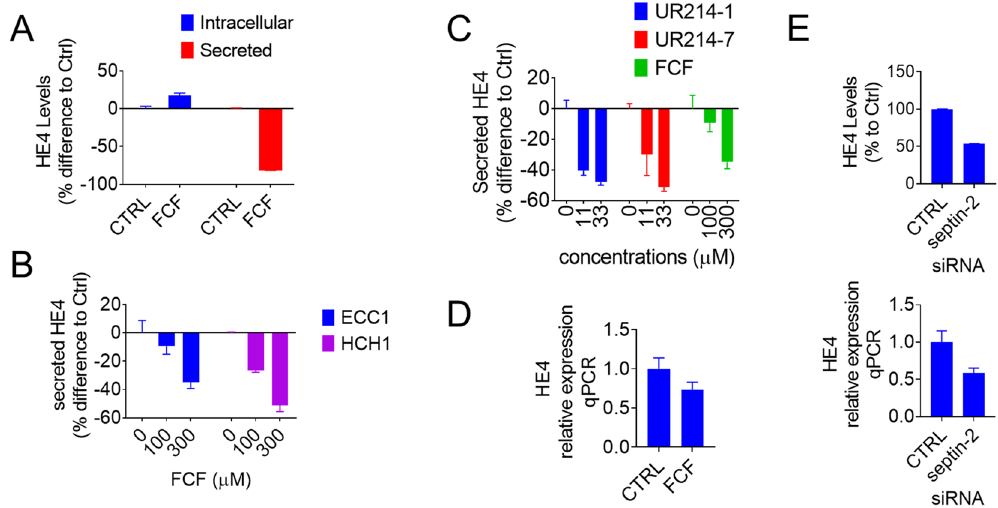
Figure 4. The effect of FCF analogs on the expression of HE4. ( A ) HE4 overexpression clones (OVCAR8-C5) were treated with or without FCF (300 µ M) for 7 h, after which the cell lysates and matching culture media were collected and analyzed for the levels of HE4 using enzyme immunoassays. The amount of secreted HE4 was normalized to the protein concentration of respective cell lysate. ( B ) ECC-1 and HCH-1 cells were treated with the indicated concentrations of FCF for 5 h and the secreted levels of HE4 were measured. ( C ) ECC-1 cells were treated with either UR214-1, UR214-7 or FCF at the concentrations indicated for 5 h at which point the secreted levels of HE4 were determined. ( D ) ECC-1 cells were washed and incubated with FCF (300 µ M) for 5 h in basal media. Relative HE4 expression was determined by real time PCR (normalized to B2M). ( E ) ECC-1 cells were transfected with septin-2 targeting siRNA or non-targeting control siRNA for 48 h (bottom) or for 72 h (top). Relative gene expression of HE4 was determined by real time PCR (normalized to TBP; bottom). The intracellular levels of HE4 were measured using enzyme immunoassays (top).